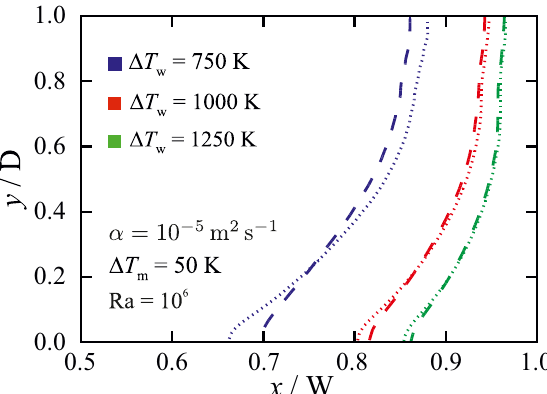
Figure 9. The influence of the permeability coefficient on predicted liquidus-line ( f L = 1) position for different wall-temperature differences ∆ T w , at ∆ T m = 50K, and Ra = 10 6 . Dashed lines: C = 1 × 10 8 kgs − 1 m − 3 ; dotted lines: C = 1 × 10 4 kgs − 1 m − 3 . The results are given for Fo = 9, in which steady-state solutions are